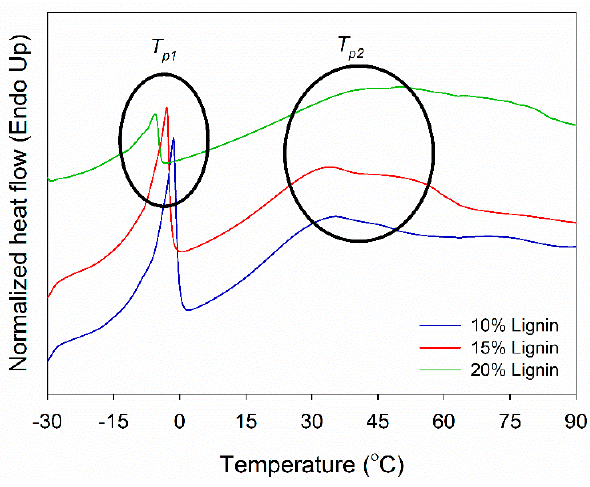
Figure 5. DSC thermograms of PVOH–lignin–hexamine blends at different contents of